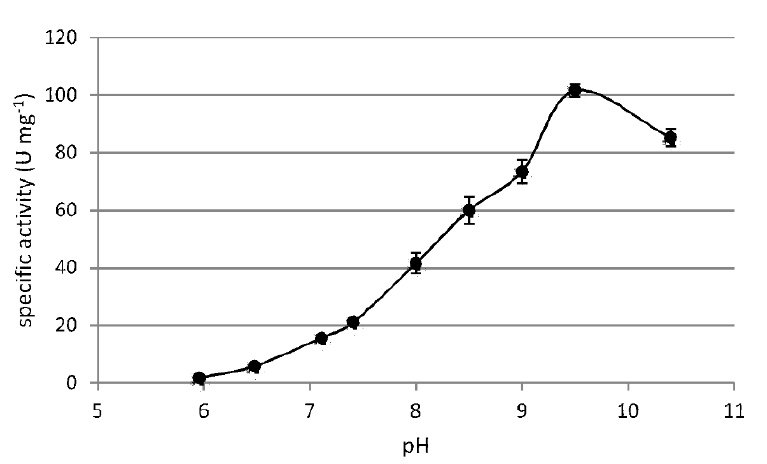
Figure 5. pH effect on the F-ALDH activity. The ALDH activity was measured at 25 ◦ C in the presence of 1 mM benzaldehyde, 1 mM NAD + and 100 mM potassium phosphate buffer (pH 6.0–7.5), TrisHCl buffer (pH 7.5–9), and glycine-KOH buffer (pH 9.0–10.5), using 0.2 µg of F-ALDH.